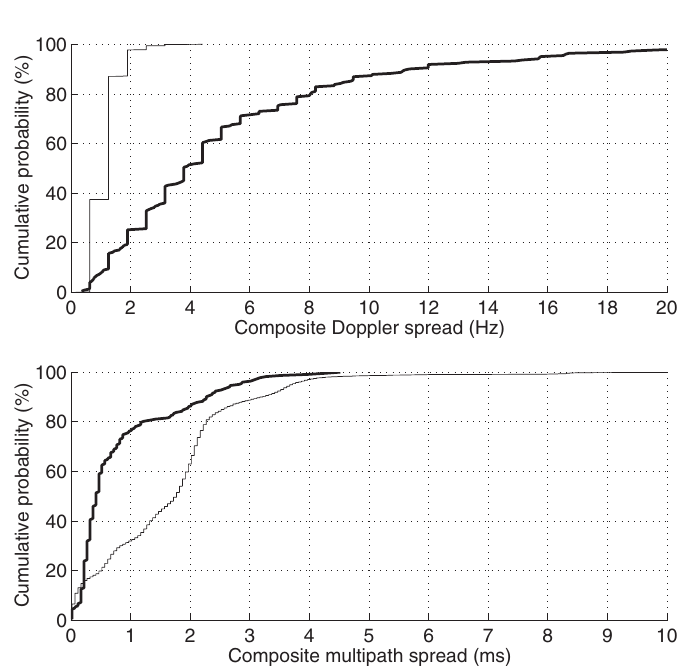
Fig. 14.4. Cumulative probability plots of composite Doppler spread ( upper frame) and composite multipath spread ( lower frame) measured at 11.12 MHz during winter. The bold curves are night time and the thin curves for day